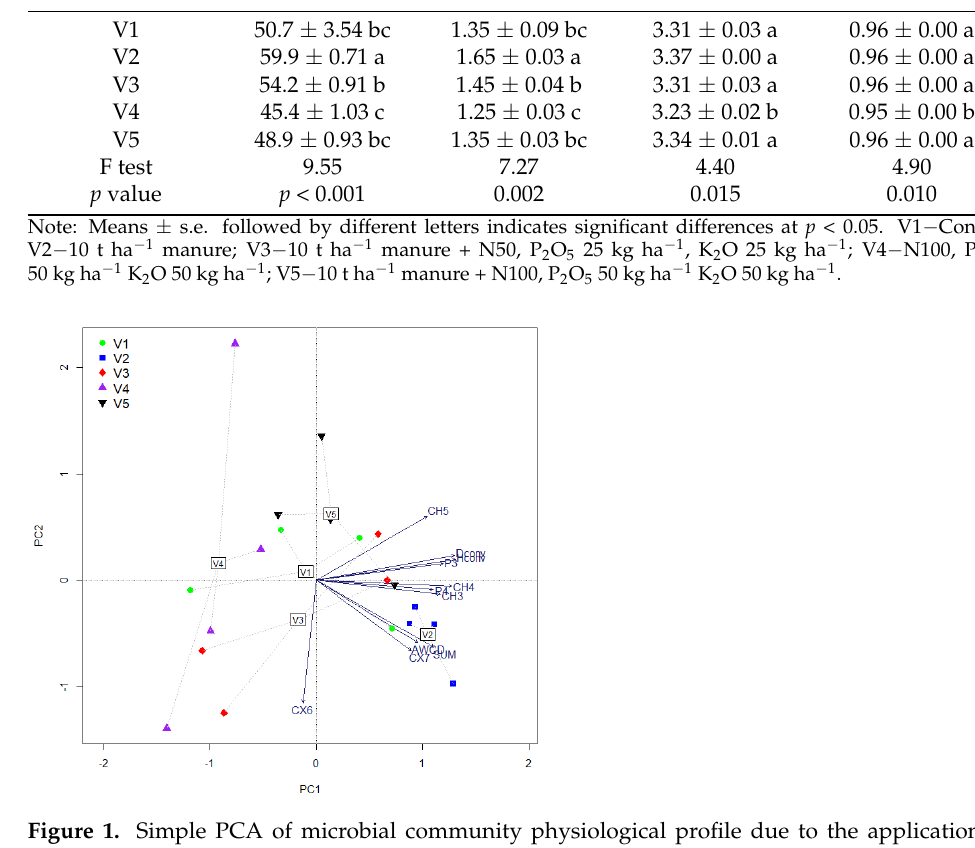
Table 1. Functional microbiome dimension and indicators due to applied treatments. Sum